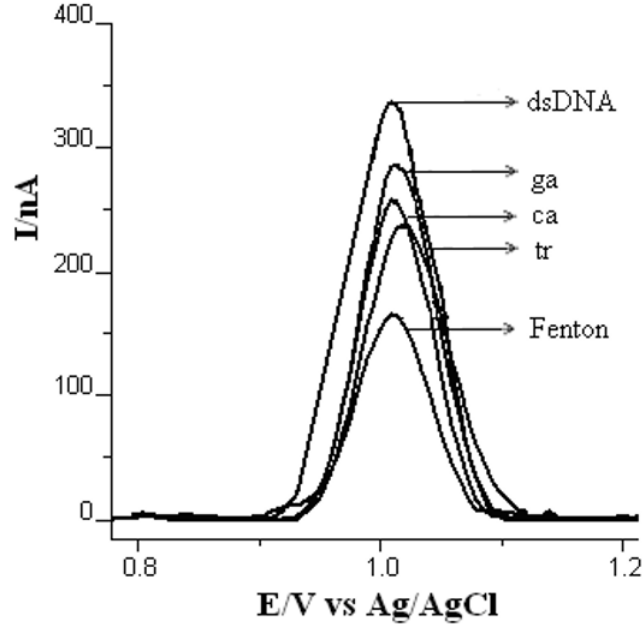
Figure 7. DPV voltammograms comparing the antioxidative ability of the phenolic acids studied (c t